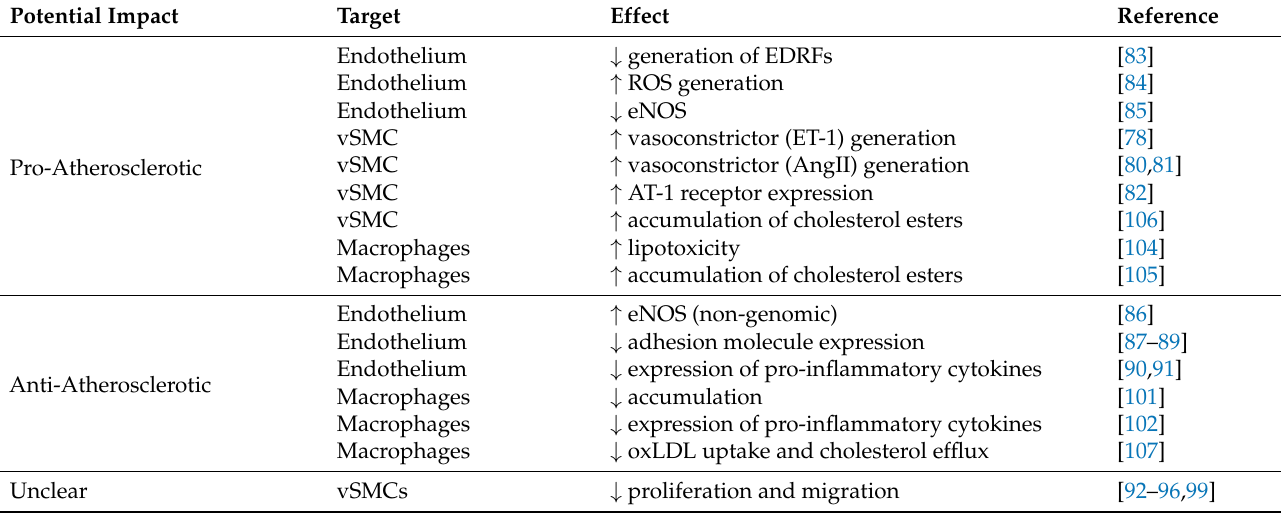
Table 2. Actions of glucocorticoids in the vessel wall that may inhibit or enhance atherosclerotic lesion formation. Potential